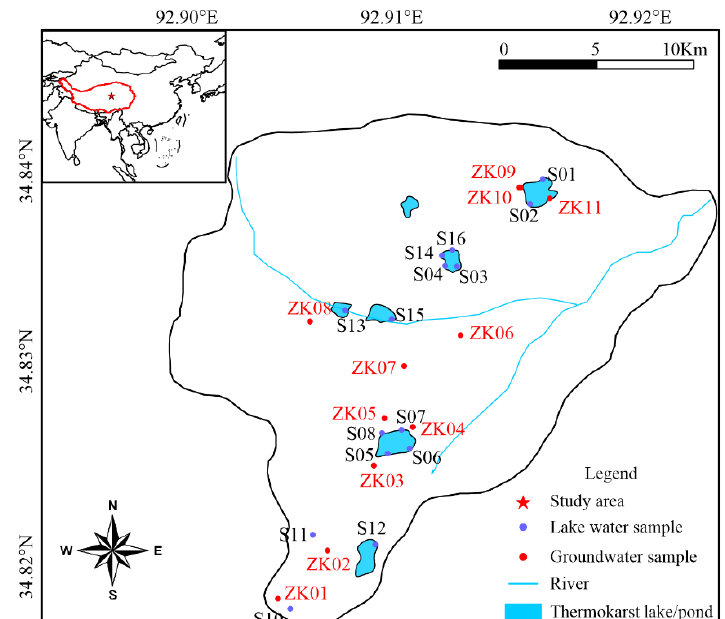
Figure 5. Locations of the sampling sites.